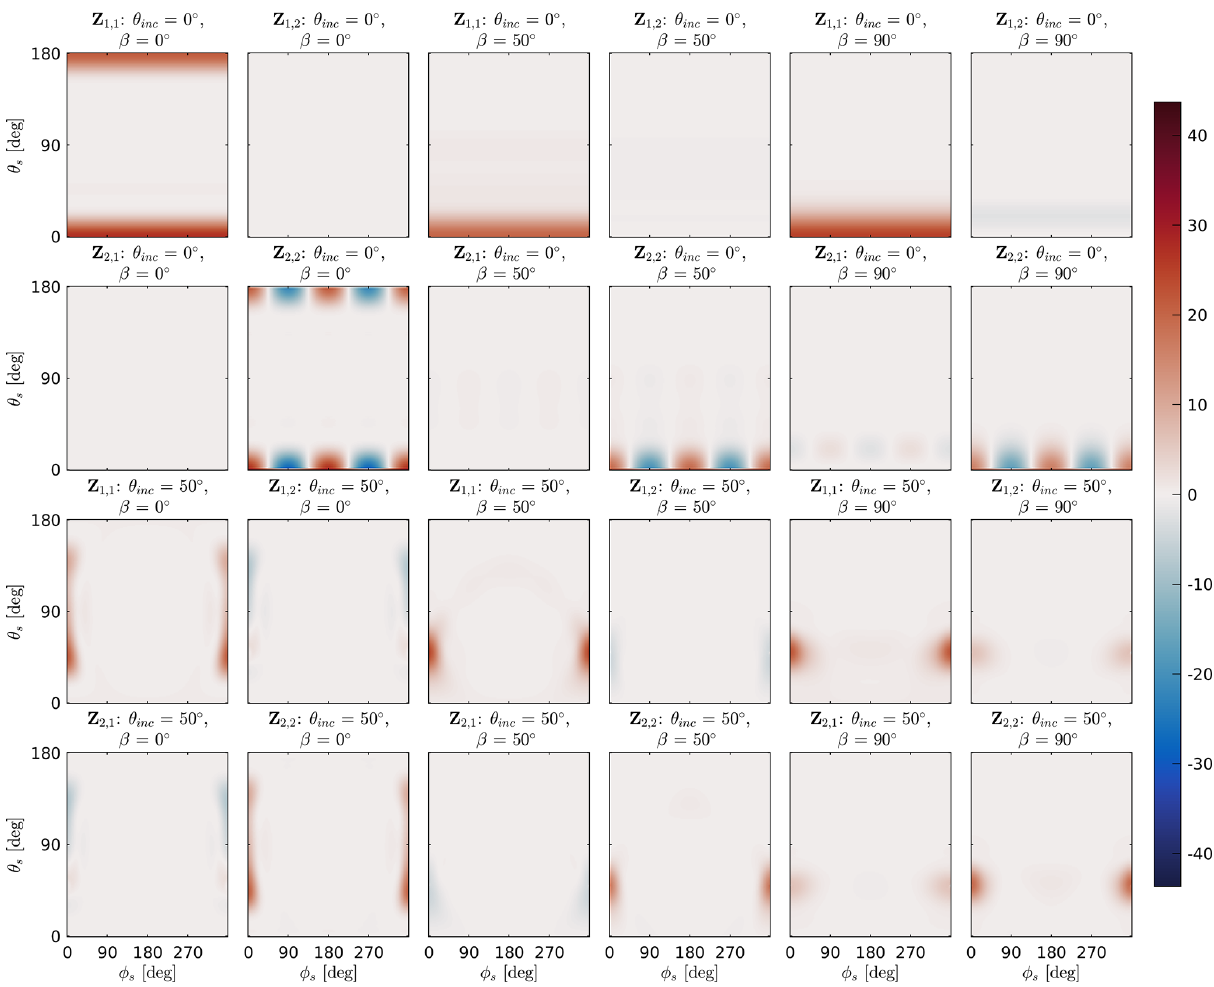
Figure 9. The upper-left block of the normalized scattering matrix ˆ Z of plate type 1 with a volume-equivalent diameter of 429µm (Fig. 4) at 671GHz, as a function of the polar scattering angle θ s and the azimuth scattering angle φ s for a set of tilt angles β and incidence angles θ inc . A volume-equivalent diameter of 429µm at 671GHz corresponds to size parameter x ≈